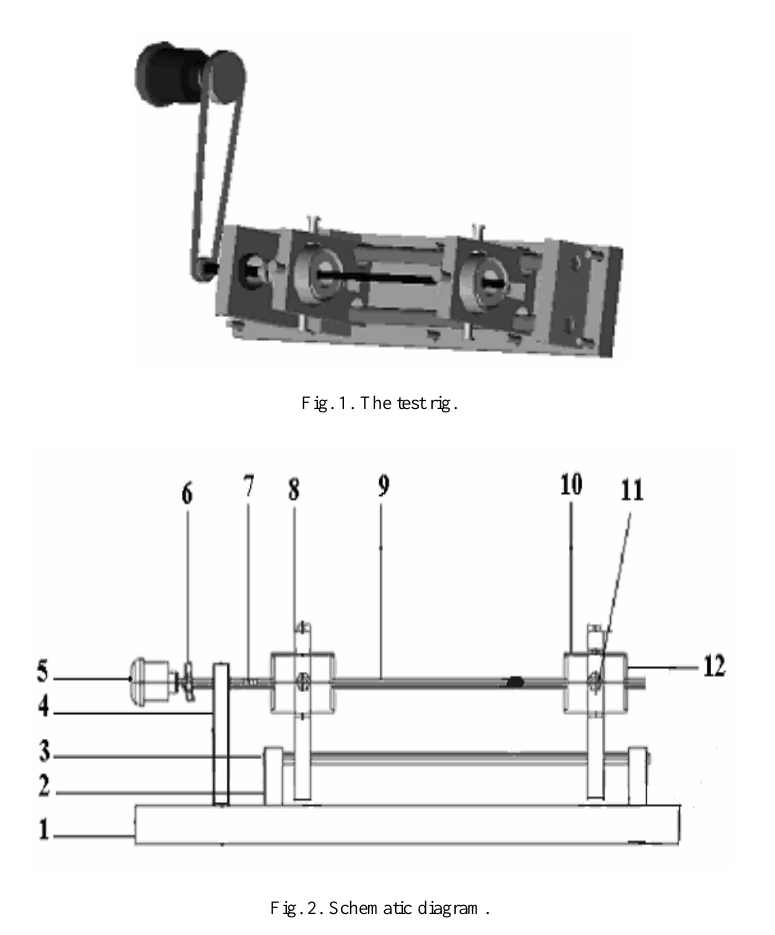
Fig. 2. Schematic